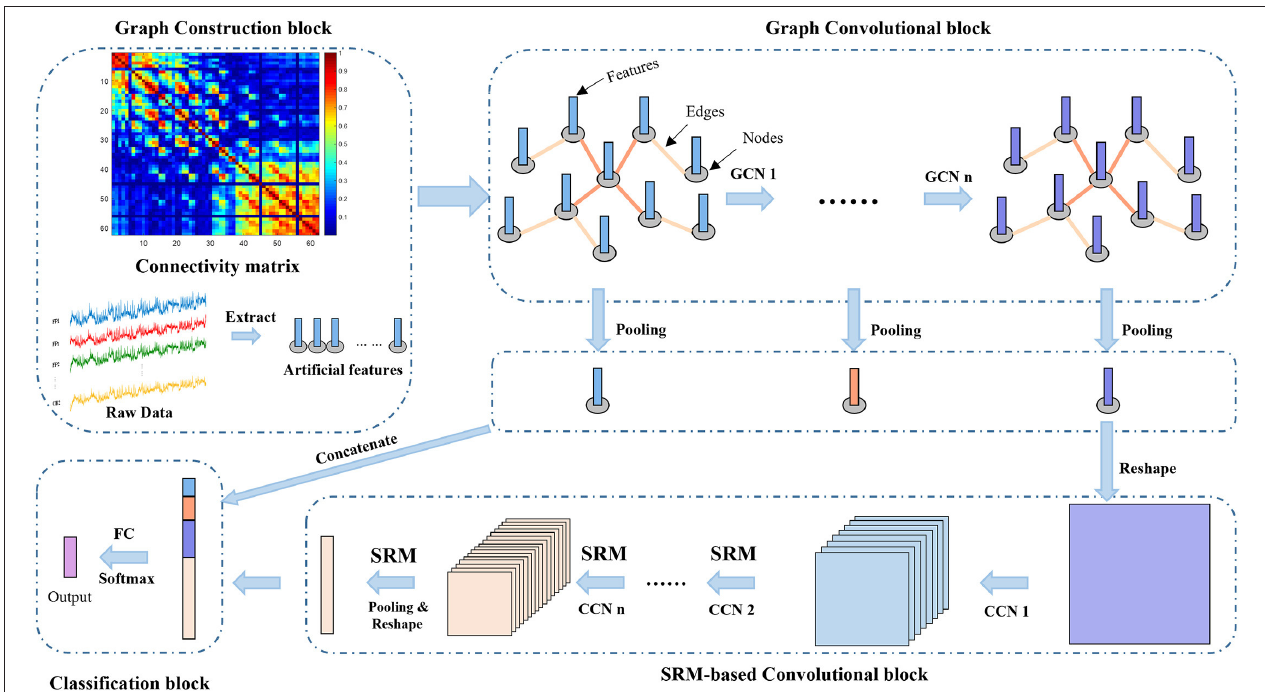
FIGURE 1 | The overall architecture of the MDGCN-SRCNN model consists of four blocks: graph construction block, graph convolutional block, SRM-based convolutional block, and classification block. The output of the model is a predicted label with probability.